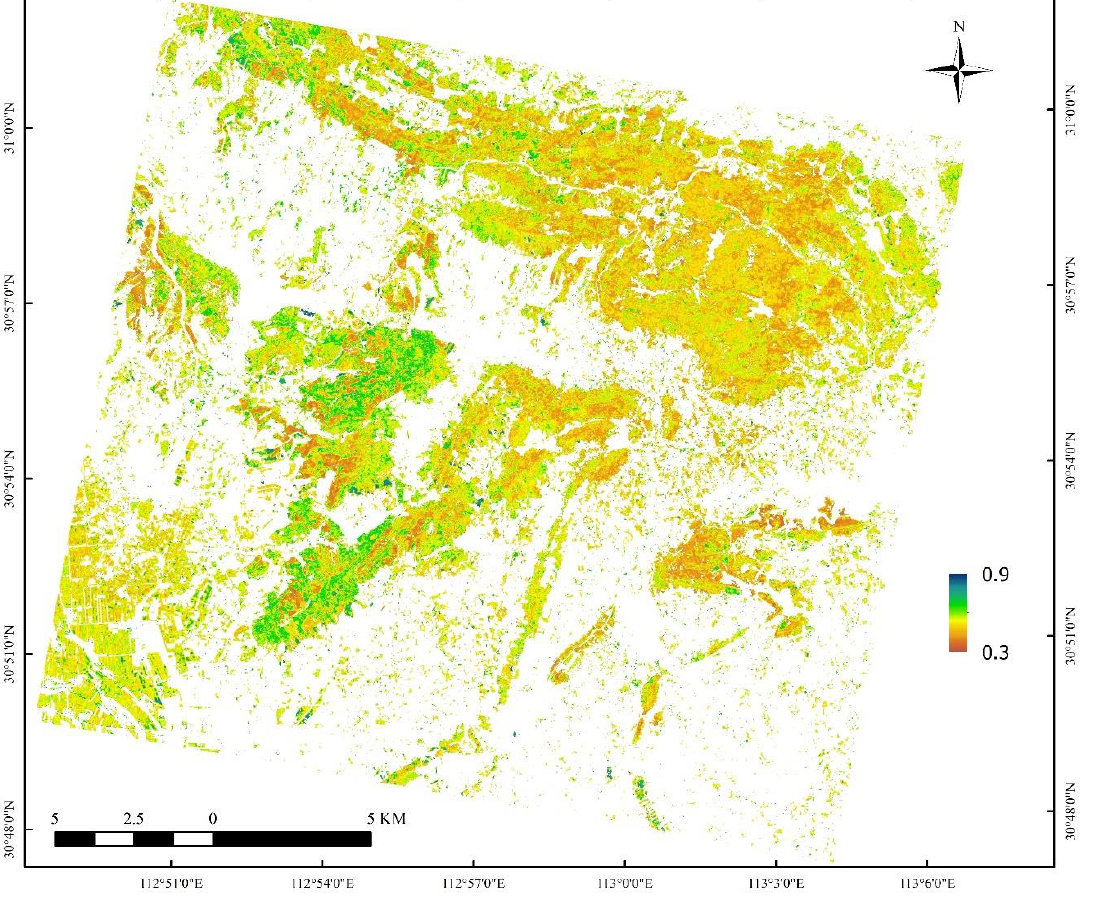
Figure 6. Predicted CC map based on the GDBoost model using GF2 imagery. Table 6. Summary of the proportion of different CC levels in the research area.